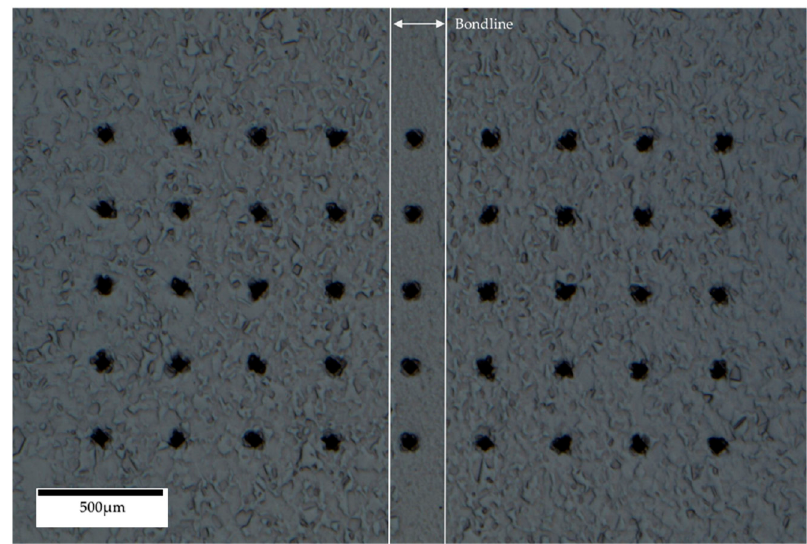
Figure 3. 9 × 5 Vickers Hardness indent grid .